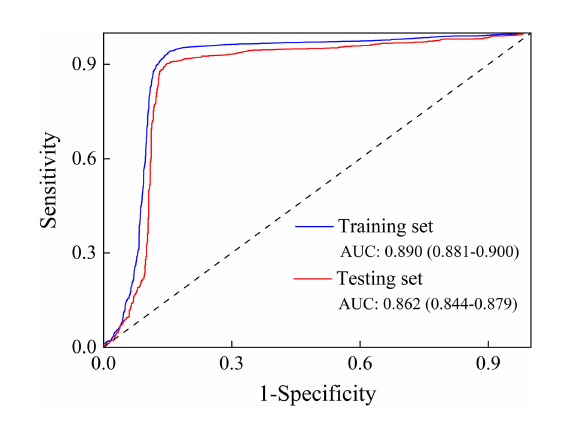
FIGURE3 The ROC curve of the training set and the testing set.